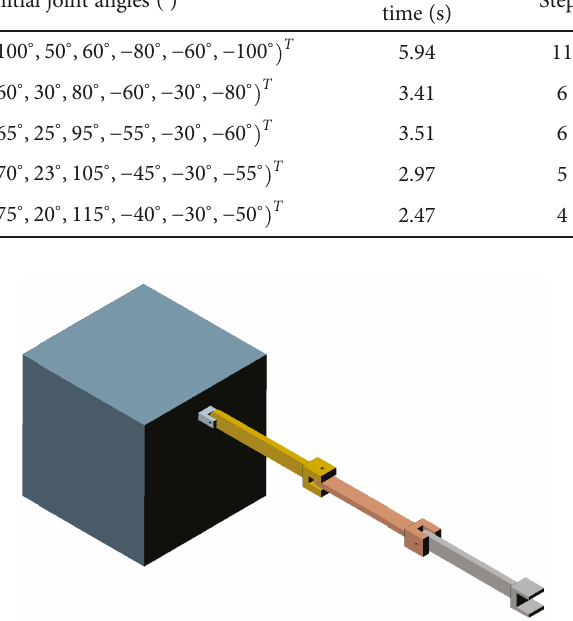
Figure 4: The Adams model of the single-arm three-link space robot at the initial con fi guration.